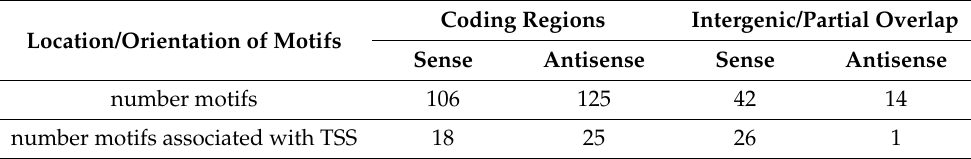
Table 2. Distribution of potential GCGC-containing promoters in the H. pylori 26695 genome pre- dicted by the Motif Locator